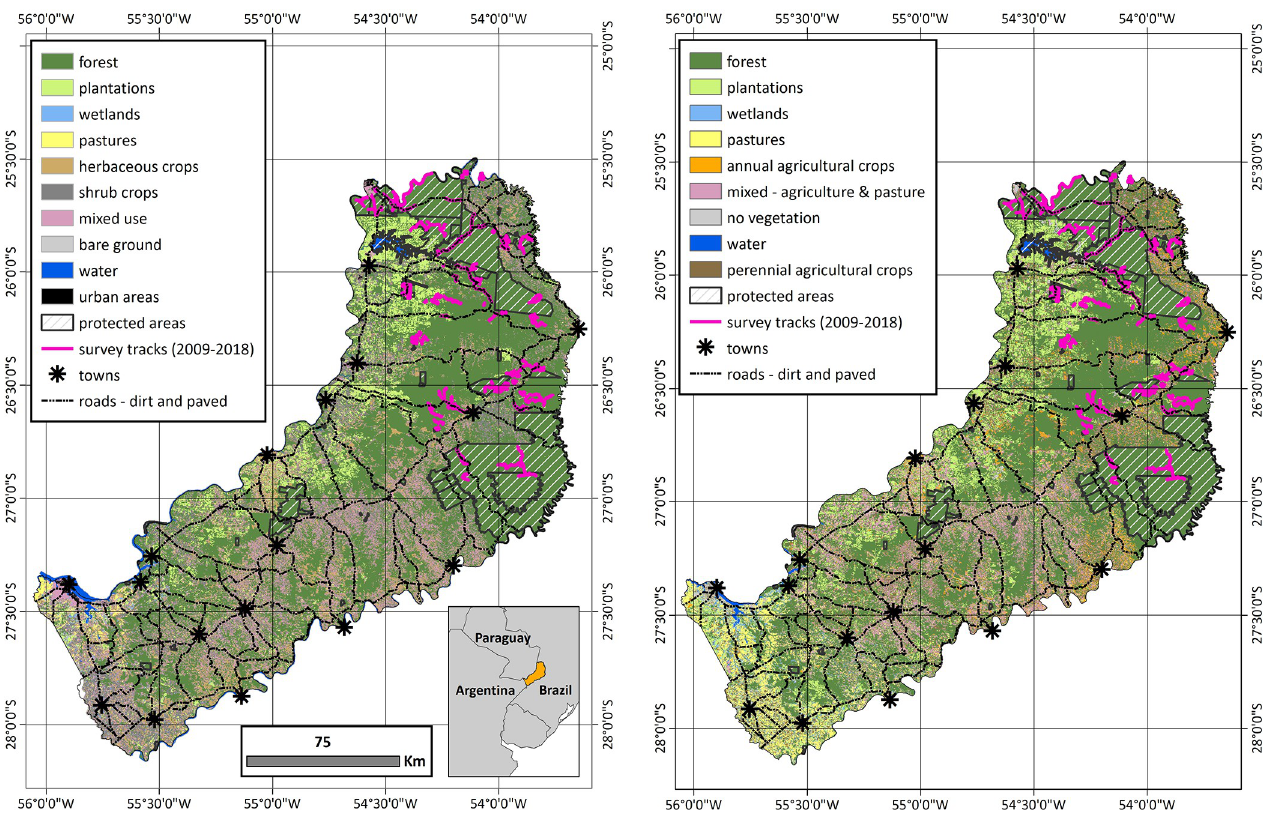
Fig 1. Map of northern-central Misiones, Argentina with detection dog survey routes (2009 thru 2018) shown relative to protected areas, major roads, towns, and the two land-use raster grids used in spatial analyses. a) land use was derived from a mosaic of Landsat-8 TM satellite images from 2015 [45] and b) land use was derived using the automated classification of satellite images from 2018